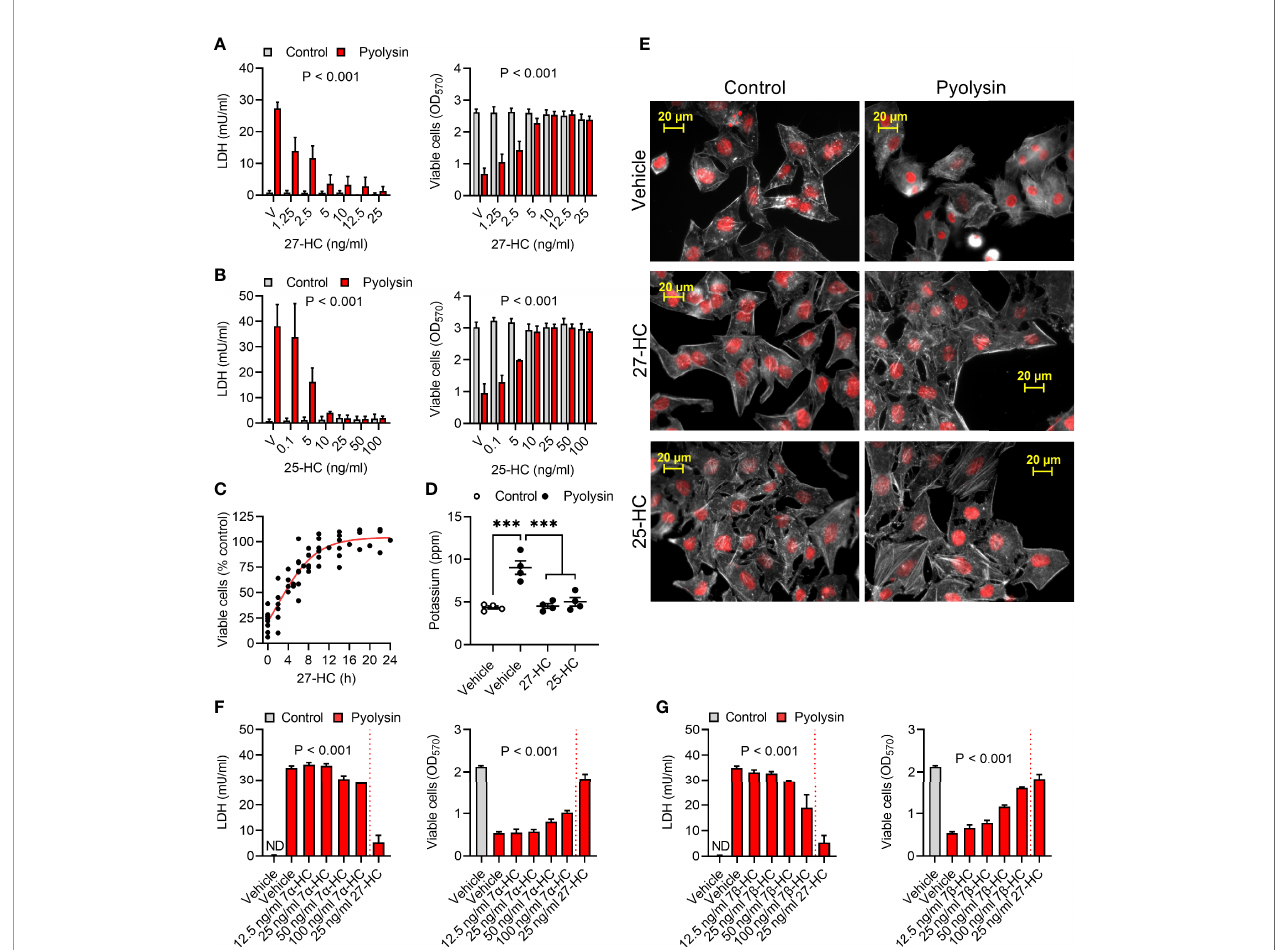
FIGURE 1 | Oxysterols protect HeLa cells against pyolysin. (A, B) HeLa cells were cultured for 24 h in serum-free medium with vehicle (V) or the indicated concentrations of (A) 27-hydroxycholesterol (27-HC) or (B) 25-hydroxycholesterol (25-HC) and then challenged for 2 h with control serum-free medium ( ■ ) or 100 HU pyolysin ( ■ ). Leakage of LDH was measured in cell supernatants, and viable cells were determined by MTT assay. Data are presented as mean + s.e.m. from 7 (A) or 3 (B) independent experiments; data were analyzed by ANOVA and P values reported for the treatment effect on pyolysin challenge. (C) HeLa cells were cultured for the indicated times in serum-free medium with 10 ng/ml 27-HC, challenged for 2 h with control serum-free medium or 100 HU pyolysin, and viable cells were determined by MTT assay. Pyolysin data are presented as percentage of control challenge; dots represent independent measurements across 5 experiments; the line is the least squares fi t. (D) Leakage of potassium from HeLa cells cultured for 24 h in serum-free medium with vehicle, 10 ng/ml 27-HC or 10 ng/ml 25-HC, and then challenged for 5 min with control serum-free medium ( ○ ) or 100 HU pyolysin ( ● ). Extracellular potassium was determined in cell supernatants by fl ame photometry. Data are presented as mean ± s.e.m. with dots representing values from 4 independent experiments; data were analyzed by ANOVA with Dunnett ’ s post hoc test, ***P < 0.001. (E) Fluorescent microscope images of HeLa cells cultured for 24 h in serum-free medium with vehicle, 10 ng/ml 27-HC or 10 ng/ml 25- HC, and then challenged for 2 h with control serum-free medium or pyolysin. Cells were stained with Alexa Fluor 555-conjugated phalloidin to visualize F-actin (white) and fl uorescent microscope images collected (nuclei are red); images are representative of 3 experiments. (F, G) HeLa cells were cultured for 24 h in serum-free medium with vehicle or the indicated concentrations of 7 a -hydroxycholesterol (7 a -HC, F), 7 b -hydroxycholesterol (7 b -HC, G) or 27-HC and then challenged for 2 h with control serum-free medium ( ■ ) or 100 HU pyolysin ( ■ ). The leakage of LDH was measured in cell supernatants, and viable cells were determined by MTT assay. Data are presented as mean + s.e.m. from 4 independent experiments; data were analyzed by ANOVA and P values reported for the effect of 7 a - hydroxycholesterol or 7 b -hydroxycholesterol on pyolysin